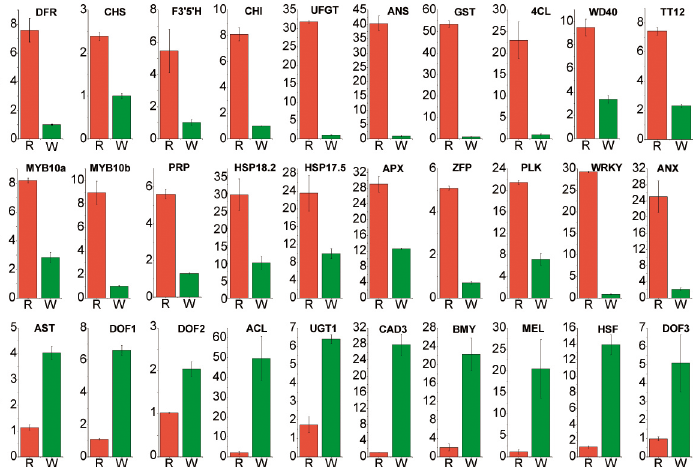
Fig 6. Verification of DEGs by qRT-PCR. The expression patterns of flavonoid synthesis-related genes in the red- and white-fleshed apples were validated by qRT-PCR. Actin was used as aninternal control.